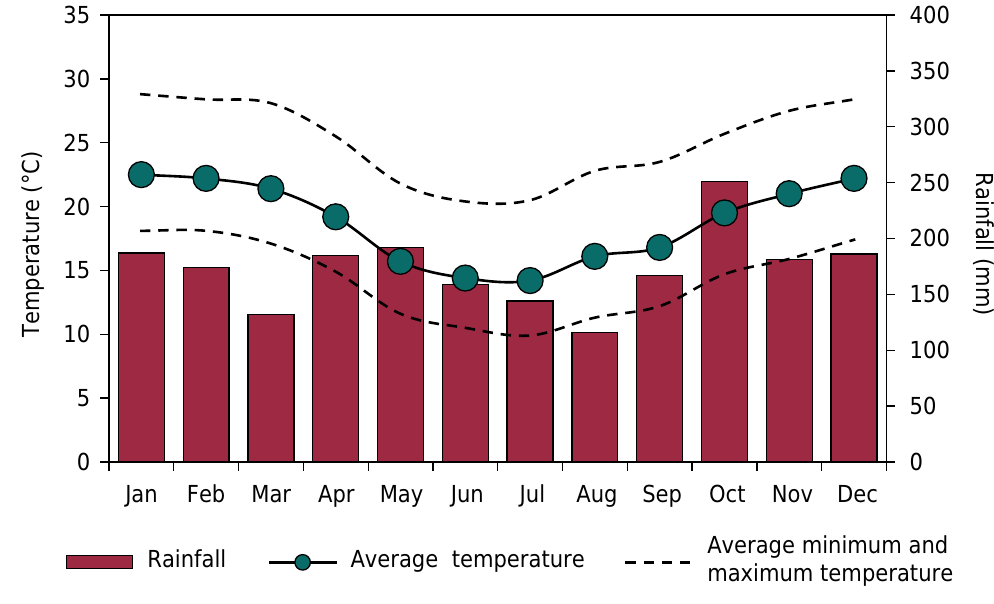
Figure 1. Average temperature and precipitation in the experimental area in the period of 1979–2014. Source: Meteorological Station of Experimental Station of IAPAR, Pato Branco, state of